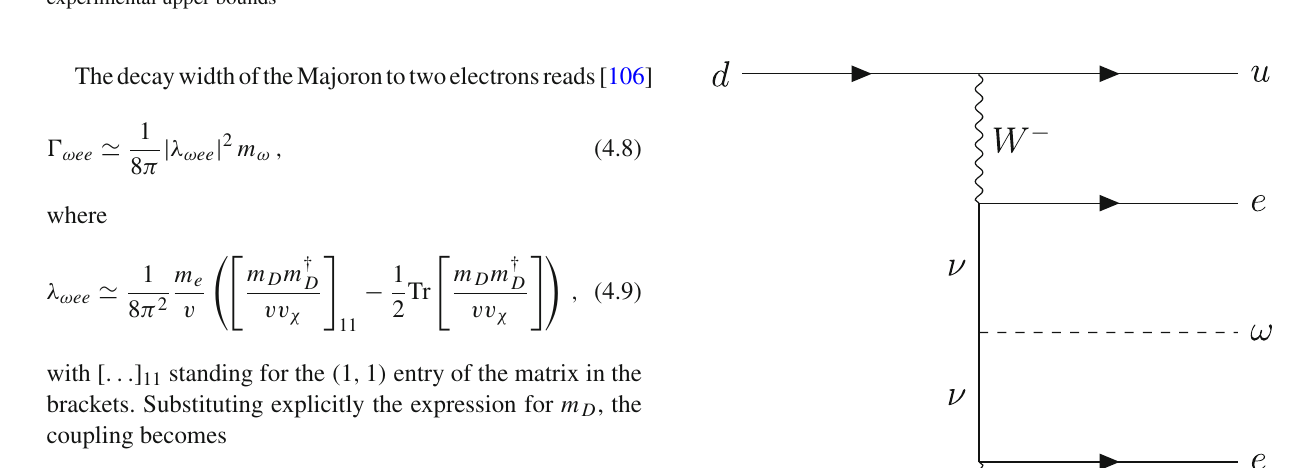
Table 3 Predictions for the Majoron effective couplings to electrons, photons and neutrinos, for the window of the parameter space where Hubble tension is alleviated. In the last line, the corresponding experimental upper bounds